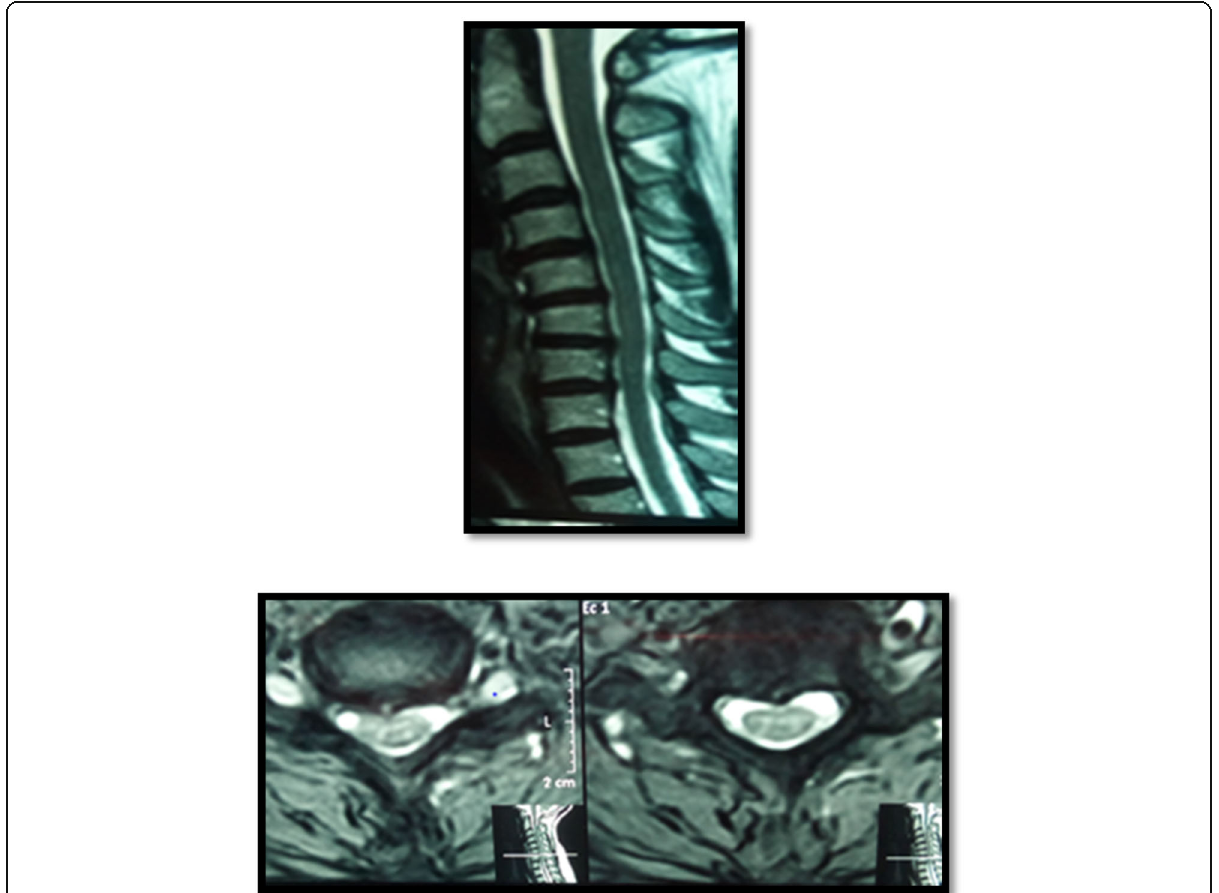
Fig. 1 MRI showed cervical disk protrusion at the level of C5 – C6 and C6 –